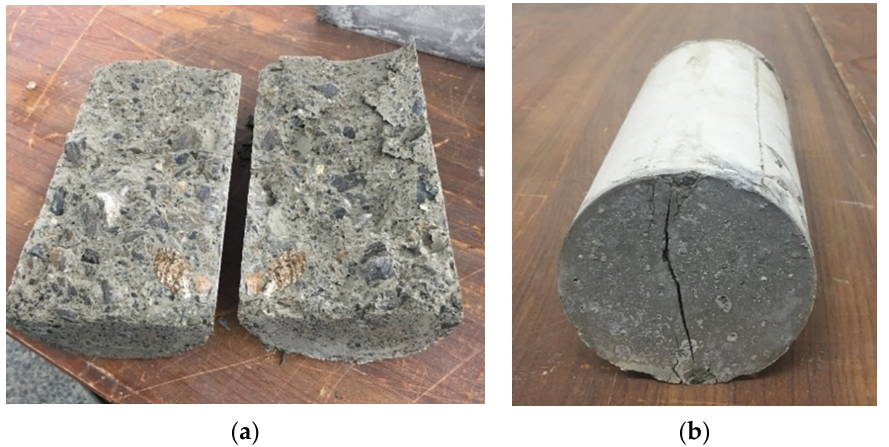
Figure 10. Failure mechanism of samples after split tensile strength. ( a ) Reference and ( b ) covered samples . ered